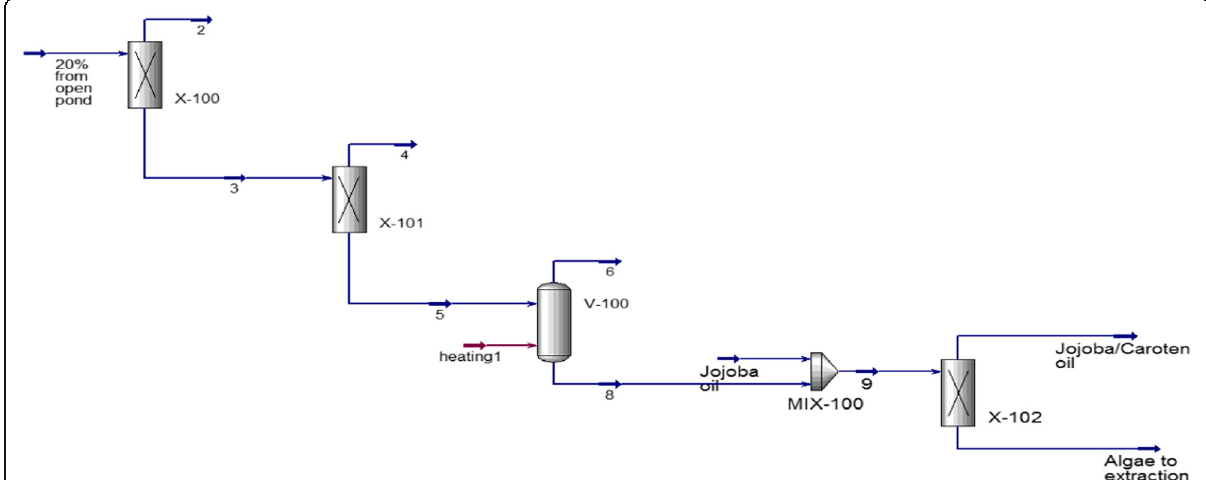
Fig. 2 Harvesting and extraction of carotenoids flow sheet, where (X-100)centrifuge, (X-101) decanter centrifuge, (V-100) sand bed dryers, (MIX- 100) mixer, and (X-102) gravity